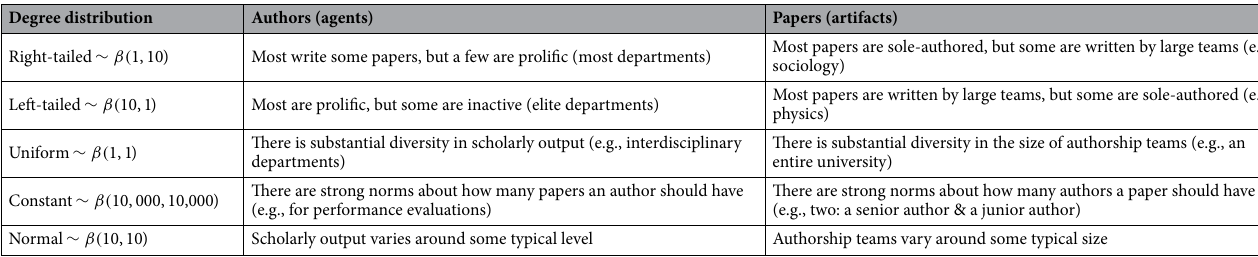
Table 2. Bipartite degree distributions, with examples in the context of a scholarly authorship bipartite